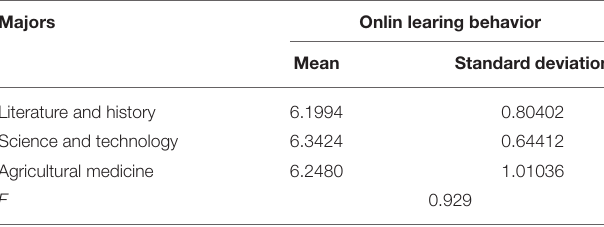
TABLE 5 | ANOVA test of different majors in Online Learning of college students.